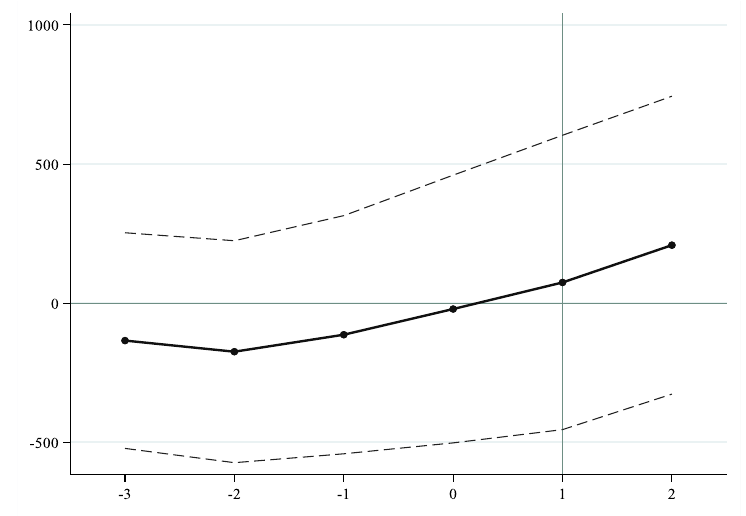
Figure 3. Difference-in-differences parallel trend test.